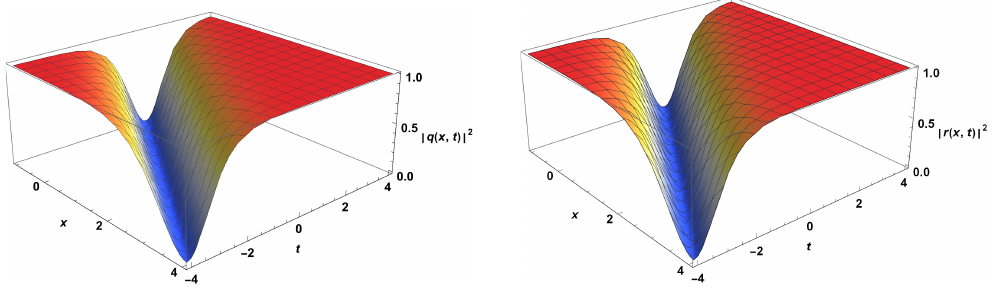
Figure 1. Surface plots of dark solitons (34) and (35) with Π = 2, a 1 = b 1 = 1, a 2 = b 2 = 1, a 3 = b 3 = 1, a 4 = b 4 = − 1, a 5 = b 5 = 1, a 6 = b 6 = 1, d 1 = 1, γ 1 = 1, µ 1 = 1, e 1 = 1, σ 1 = 1, and α 1 = α 2 = 1.